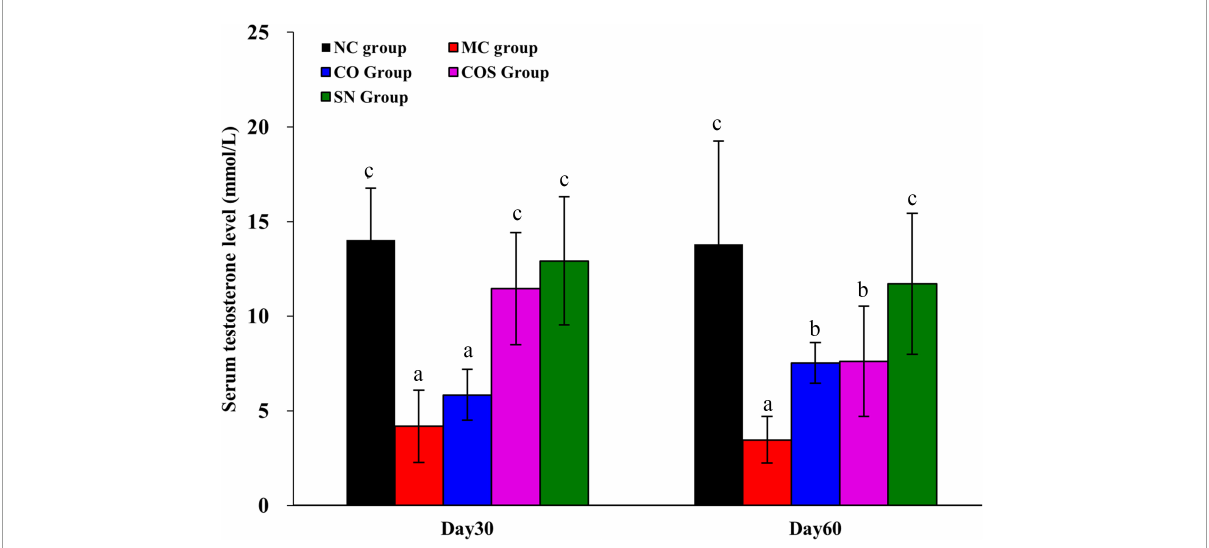
FIGURE3 After the end of modeling, serum testosterone levels of hyperlipidemia-induced reproductive damage rats at the another 30th and 60th day by feeding test substance. NC, normal control; MC, model control; CO, Camellia oil; COS, Camellia oil + squalene; SN, sildenafil. All values are expressed as mean ± SD. Different letters represent significant differences ( p < 0.05).